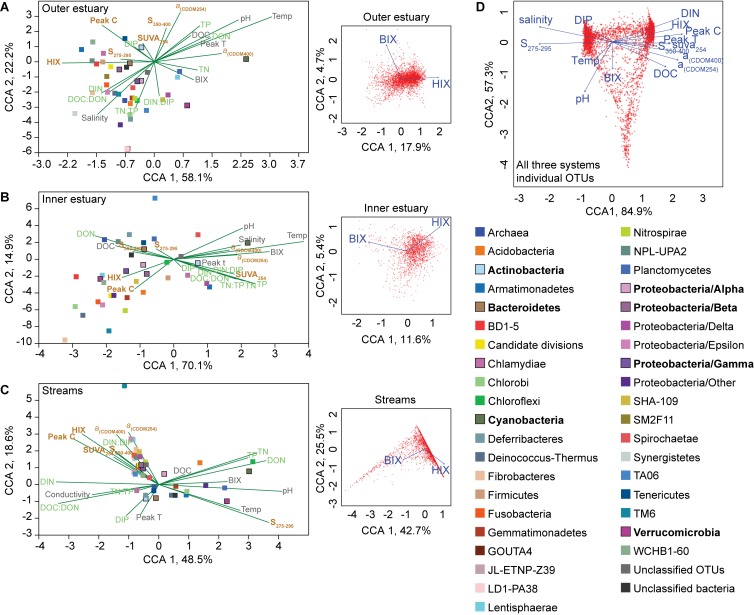
Canonical correspondence analyses (CCAs) for the “outer estuary (A), “inner estuary” (B), and the five streams (C). The CCAs were based on the chemistry/optical data and the relative abundance of phyla (Proteobacteria were divided into classes). The text colors in the CCAs denote abiotic factors (gray) and further division into nutrient-related (green) or DOM characteristics (brown). The insert subgraphs to the right of each main graphs show CCAs based on all OTUs and the BIX and HIX variables as environmental parameters. The color legend on the right side correspond to the taxonomic groups in the main graph CCAs showing different phyla and proteobacteria classes. Taxa with high relative abundance (as shown in Figure 2) are denoted by bold text and bold outlines on the respective square symbols. (D) CCA based on all OTUs from all three study systems (streams, inner, and outer estuary). See Figure 3 for abbreviations and explanations of the chemical and optical variables.